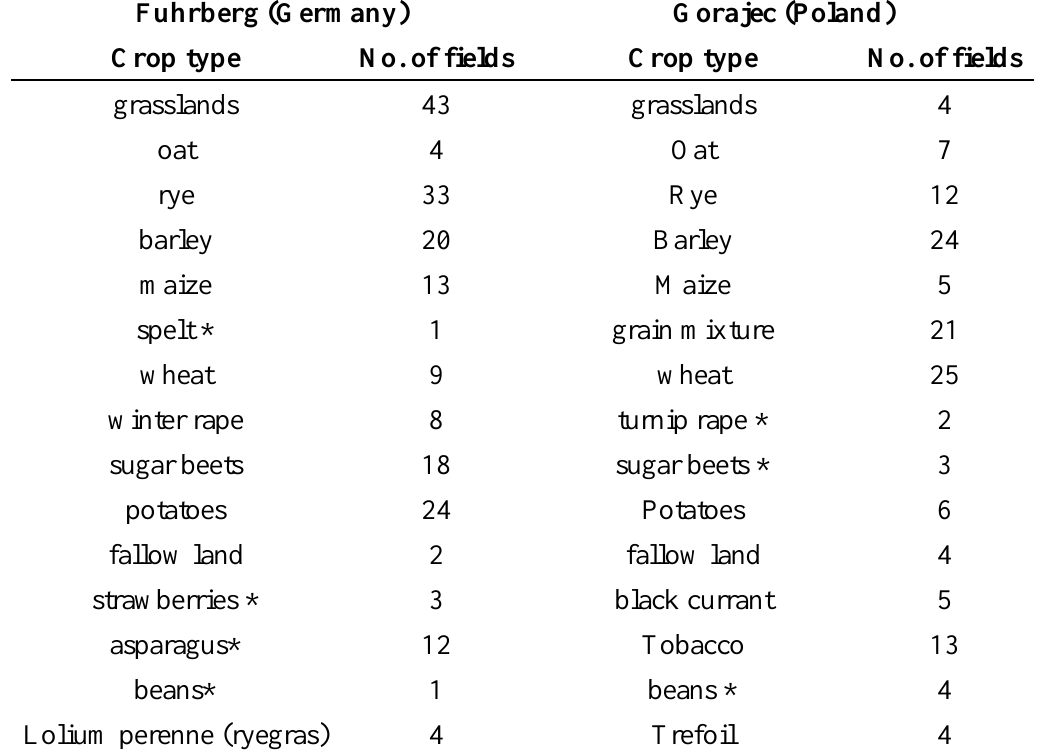
Table 2. Land cover type and number of plots in the study